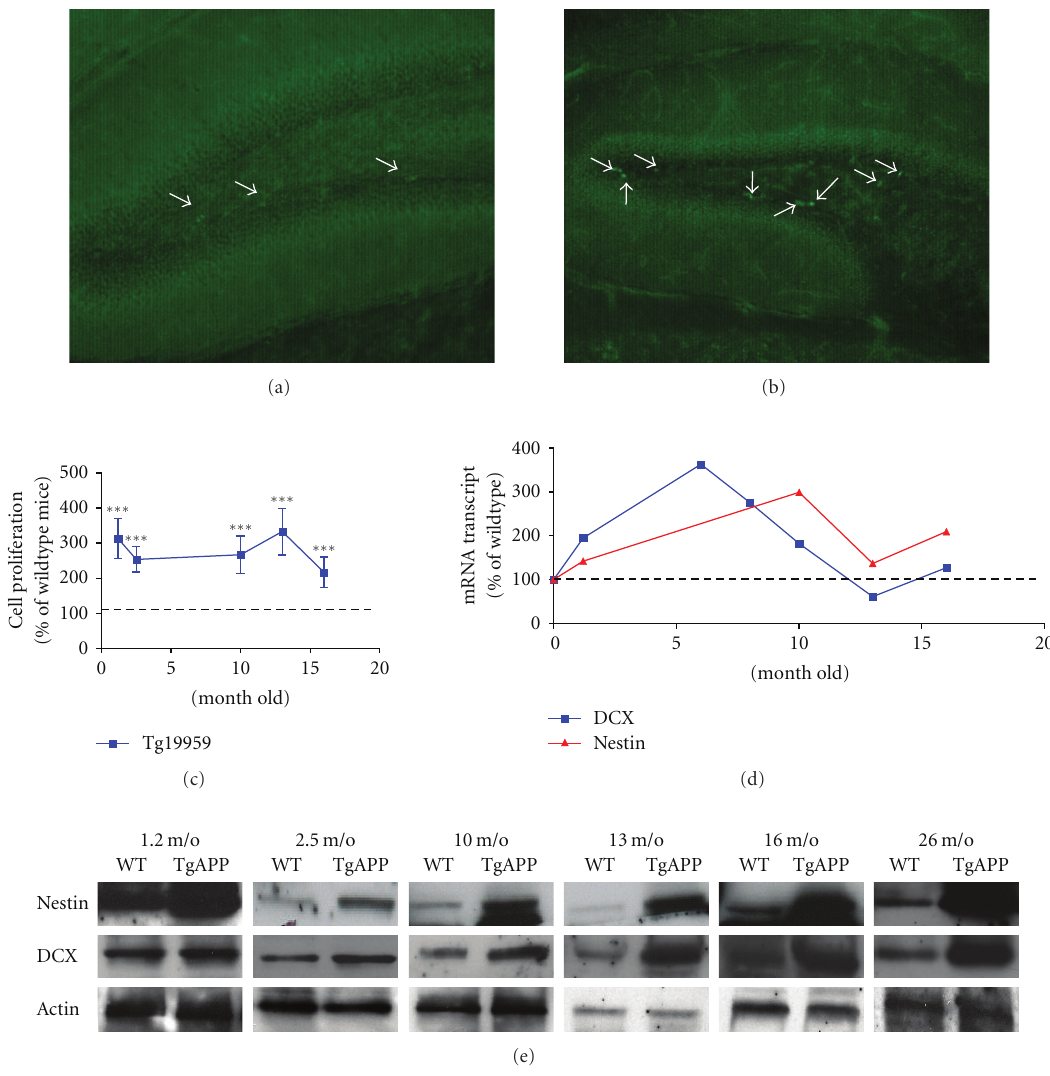
Figure 2: Tg-19959 mice exhibit increased proliferation in the dentate gyrus at all ages. We measured Ki67, a marker of cell proliferation in the dentate gyrus of wild type and Tg-19959 mice at di ff erent ages. There is significant increase in NSC proliferation in 5-week-old Tg-19959 mice (b) versus littermates wild type (a) that is maintained over time as animals aged (c). The markers of nestin (neural progenitor marker) and doublecortin (DCX, neuronal progenitor marker) were also significantly increased versus wild type in both mRNA (d) and protein (e) levels in hippocampus at all